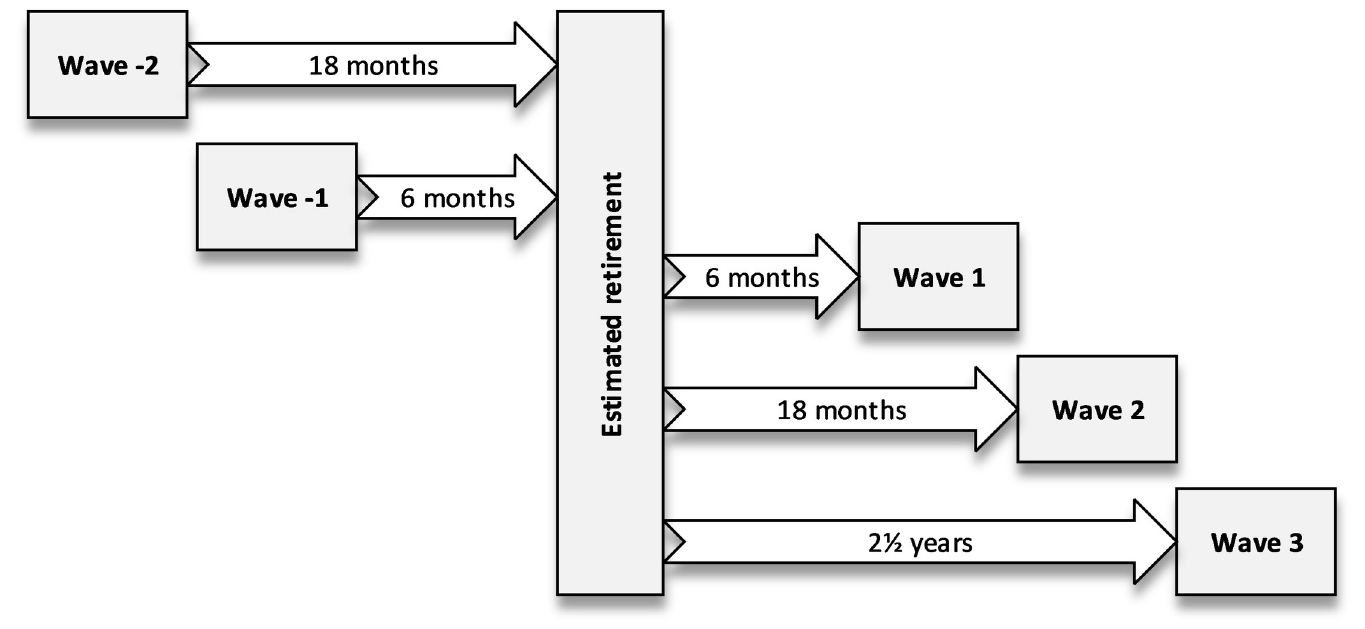
Fig 1. Study waves and follow-up